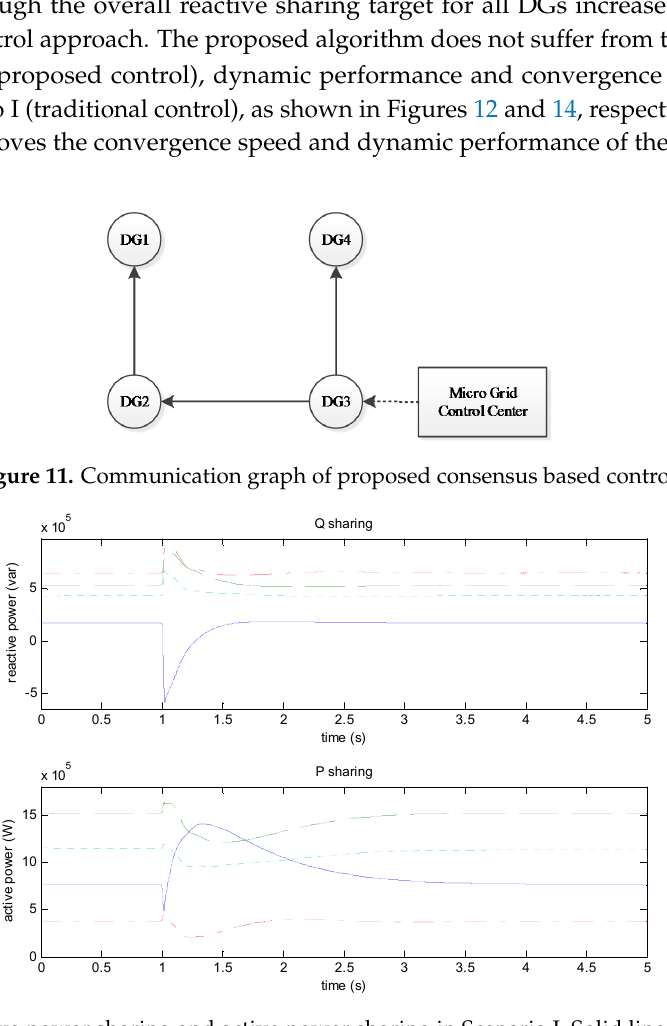
Table 6. Summary of Simulation Results in Scenario I.